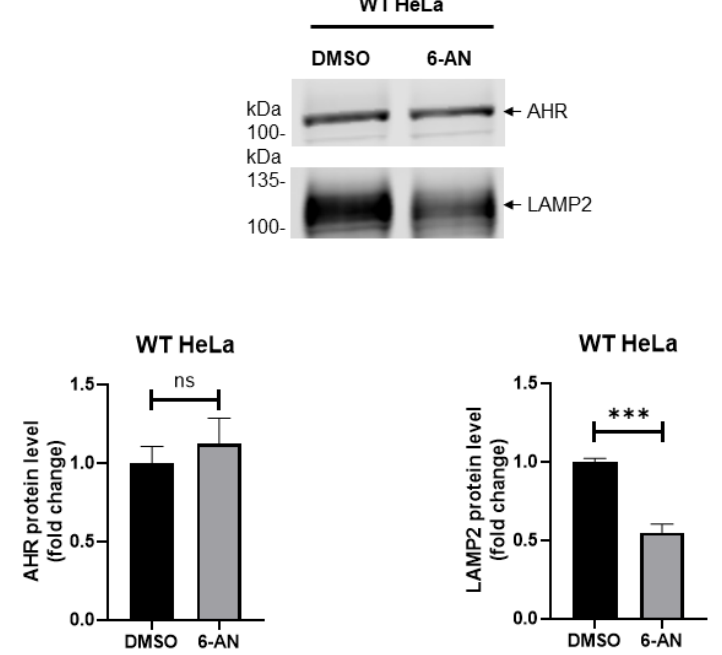
Figure 8. Activation of chaperone-mediated autophagy does not degrade AHR in HeLa cells. Wild type (WT) HeLa cells were treated with a chaperone-mediated autophagy activator 6-aminonicotinamide (6-AN, 100 µ M) for 24 h. Treatment of 6-AN did not change AHR protein levels (bottom left graph) but reduced LAMP2 levels (bottom right graph). Images above are representative of triplicate samples in one experiment and this experiment was repeated once with similar results. Each Western lane contained 30 µ g of whole-cell lysate. Data are normalized by the total protein stain. The plots represent means ± SD, n = 3. An unpaired t -test was used to determine statistical significance.